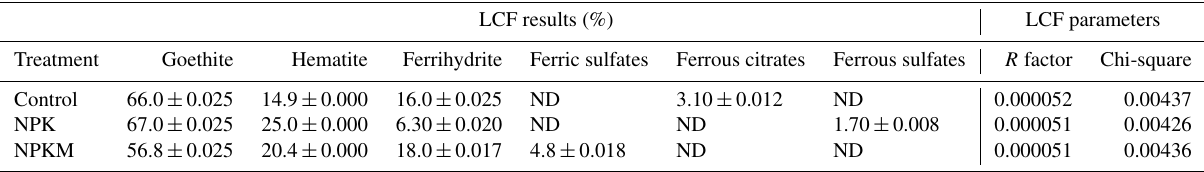
Table 3. Linear combination fit (LCF) results of Fe K-edge XANES spectra of the soil colloids from three separate long-term (1990–2014) fertilization treatments a .